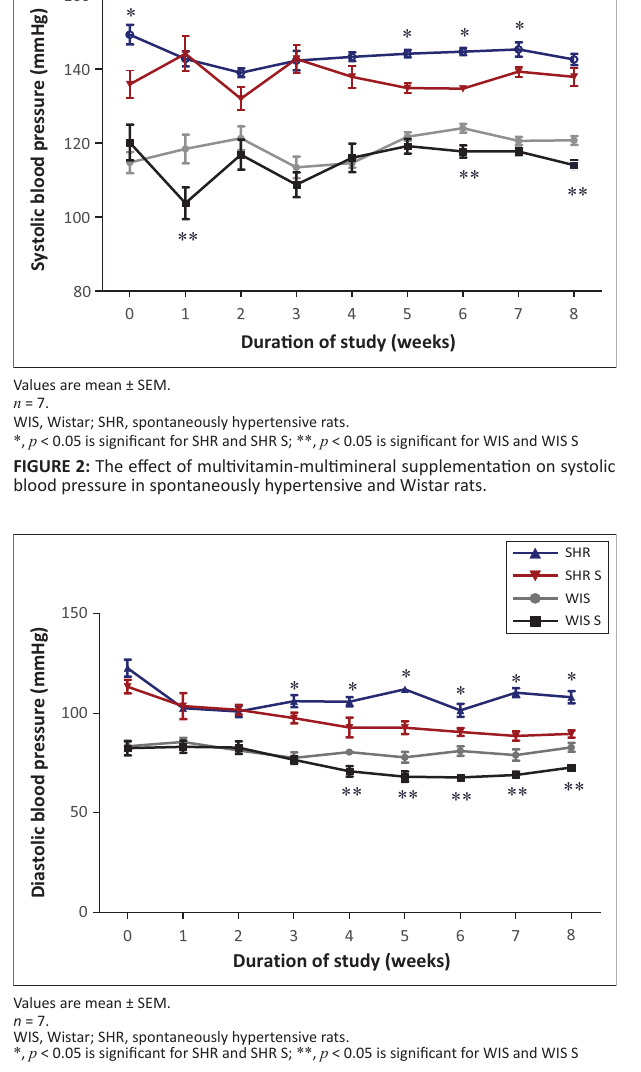
FIGURE 3: The effect of multivitamin-multimineral supplementation on diastolic blood pressure in spontaneously hypertensive and Wistar rats. TABLE 2: Effect of multivitamin-multimineral supplementation on red blood cell count, white blood cell count, haematocrit and haemoglobin in spontaneously hypertensive and Wistar rats for week eight.